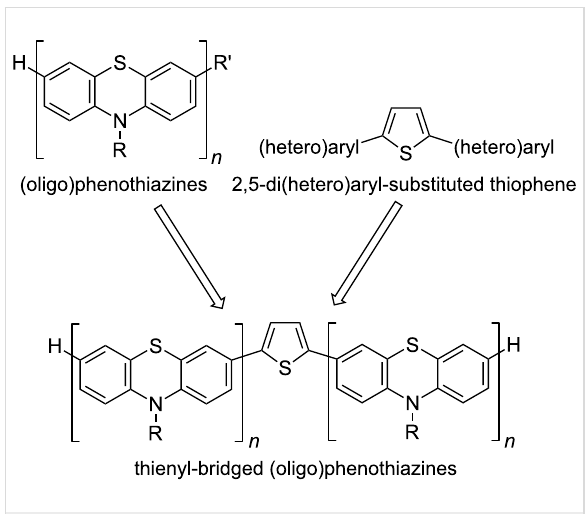
Figure 1: Thienyl-bridged oligophenothiazines as topological hybrids of (oligo)phenothiazines and 2,5-di(hetero)aryl substituted